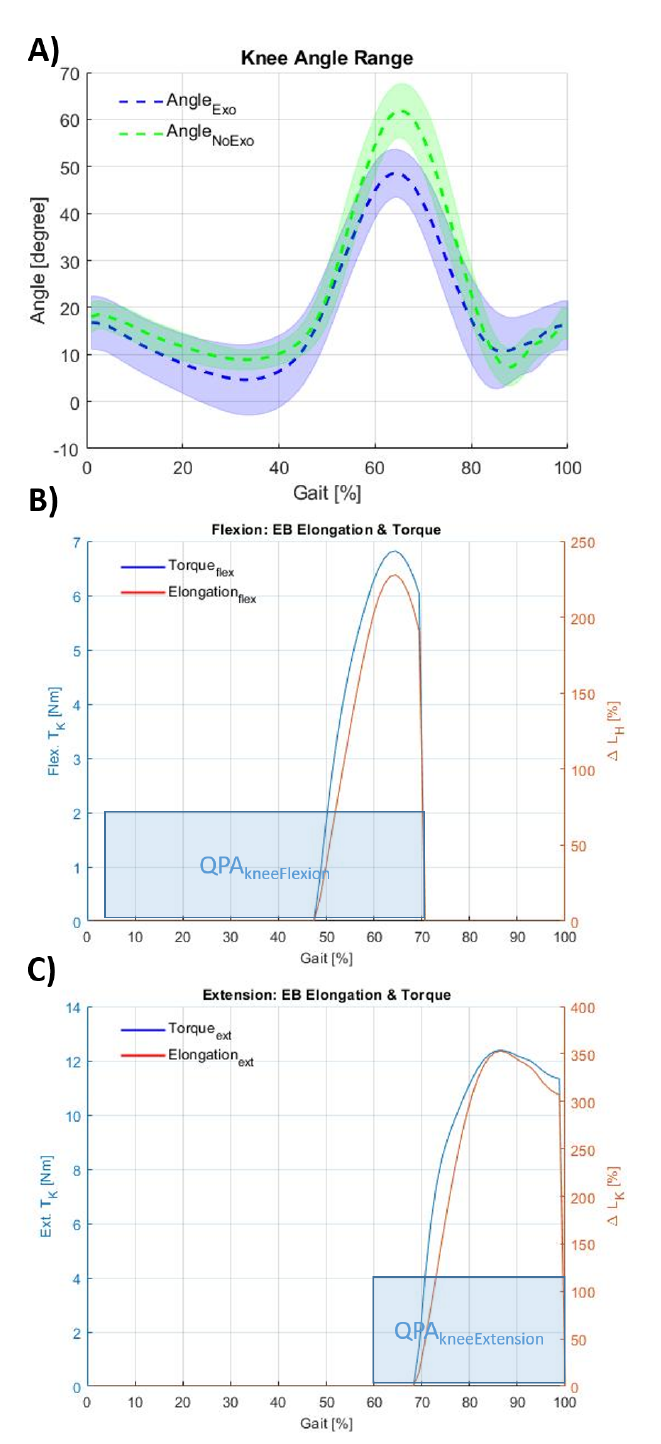
Figure 8. ( A ) Knee angle range wearing XoSoft and not wearing XoSoft. ( B ) Knee flexion resistive torque and EB elongation generated by the XoSoft, and the gait portion when the QPA kneeFlexion is engaged. ( C ) Knee extension resistive torque and EB elongation generated by the XoSoft, and the gait portion when the QPA kneeExtension is